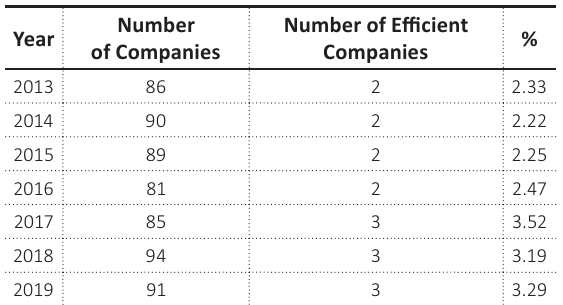
product efficiency for the period 2013–2019